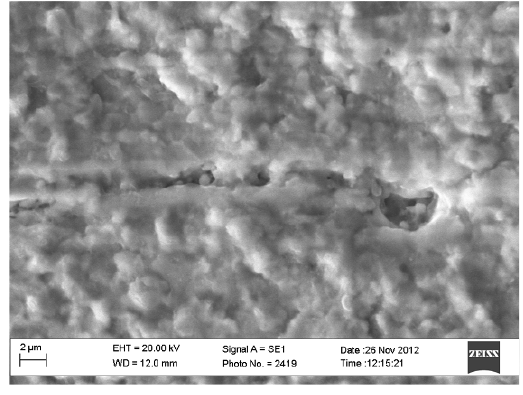
Figure 5. Surface morphology of Ti-6Al-4V alloy after high- Figure 3. Potentiodynamic polarization curves of Ti-6Al-4V alloy in 0.9% NaCl at 40 o C after nitriding (1); low-temperature temperature oxidation of nitride coating based on Ti oxidation (2) and high-temperature oxidation (3) of phase resulting from potentiodynamic polarization in nitride coating based on Ti N phase. 0.9% NaCl at 40 o 2